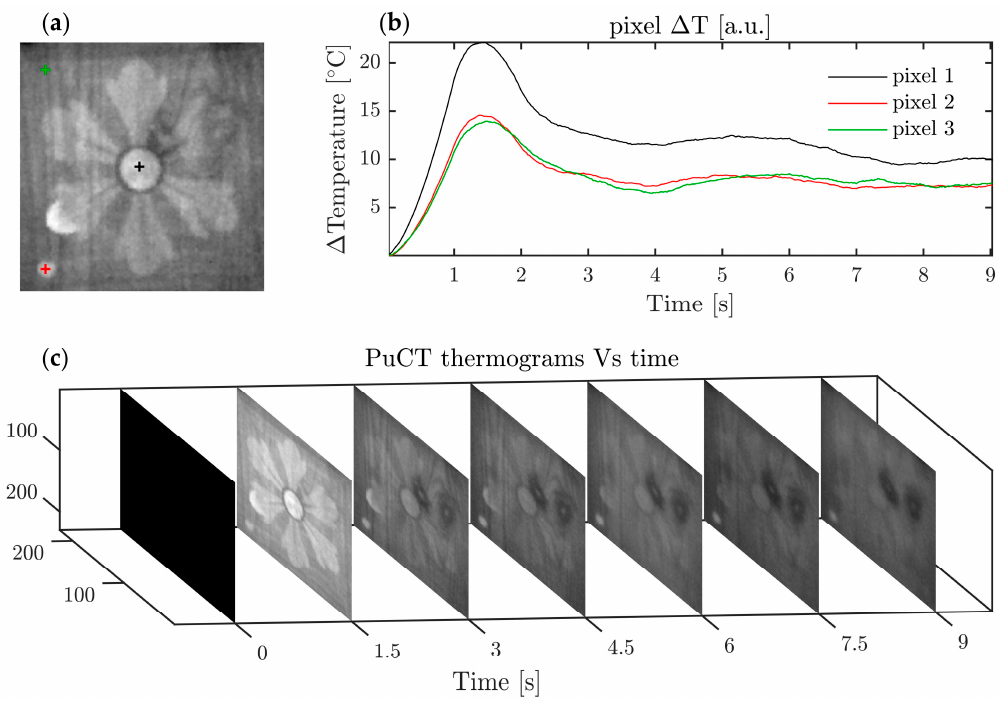
Figure 7. PuCT experimental data collected with Xenics Onca-MWIR-InSb, i.e., setup (b) in Fig. 3: ( a ) selected pixels marked; ( b ) marked pixels’ equivalent temperature rise after PuC; ( c ) selected thermograms after PuC.